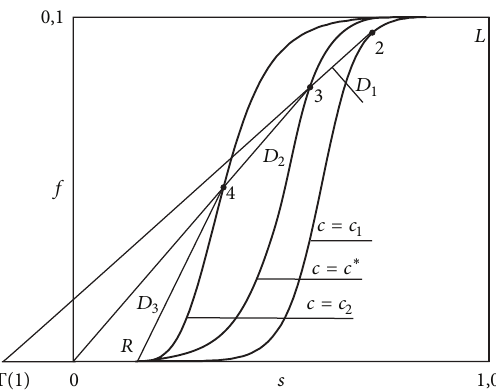
Figure 1: Fractional flow curves and Riemann problem solution, where 𝑐 1 is the slug concentration, 𝑐 2 is the initial concentration, and 𝑐 ∗ is the intermediate